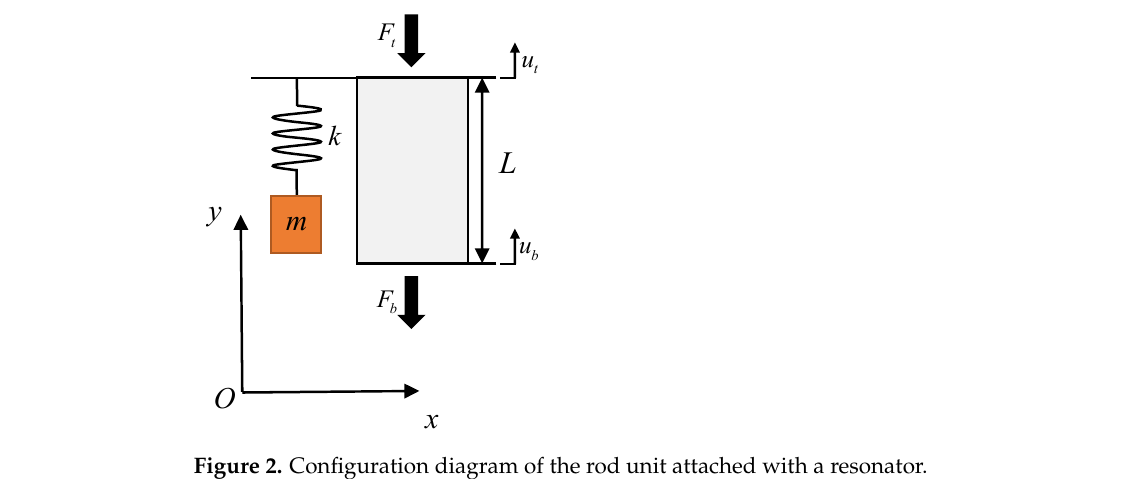
Figure 2. Configuration diagram of the rod unit attached with a resonator.